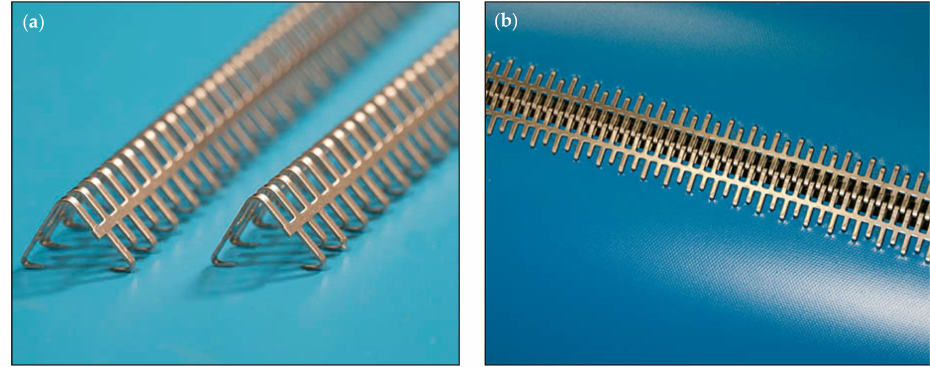
Figure 17. Metal legs fastening: ( a ) general view; ( b ) fastener installed on the belt [25].